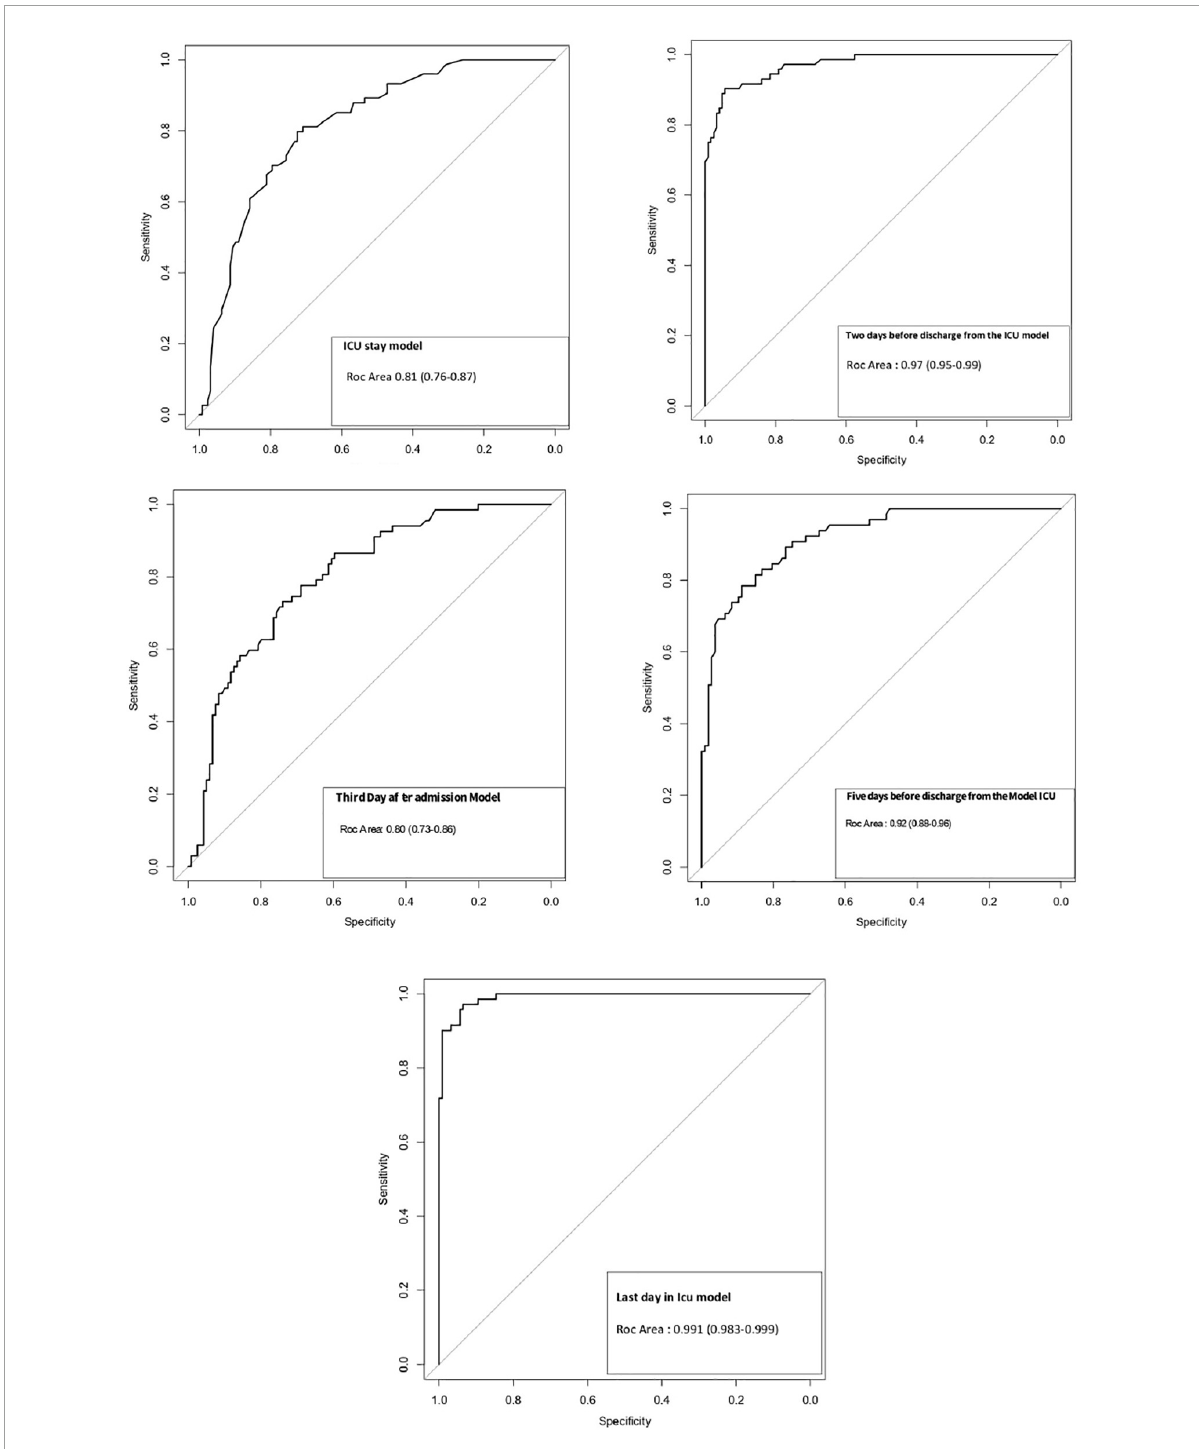
FIGURE3 Receiver operating characteristic (ROC) area of multiple logistic regression models.